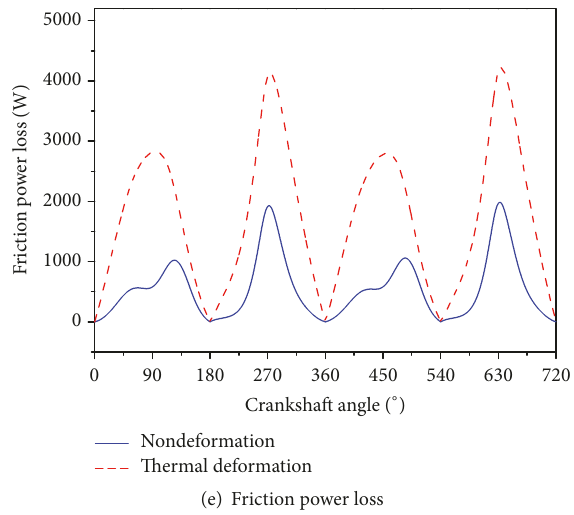
Figure 22: Effect of thermal deformation on lubrication